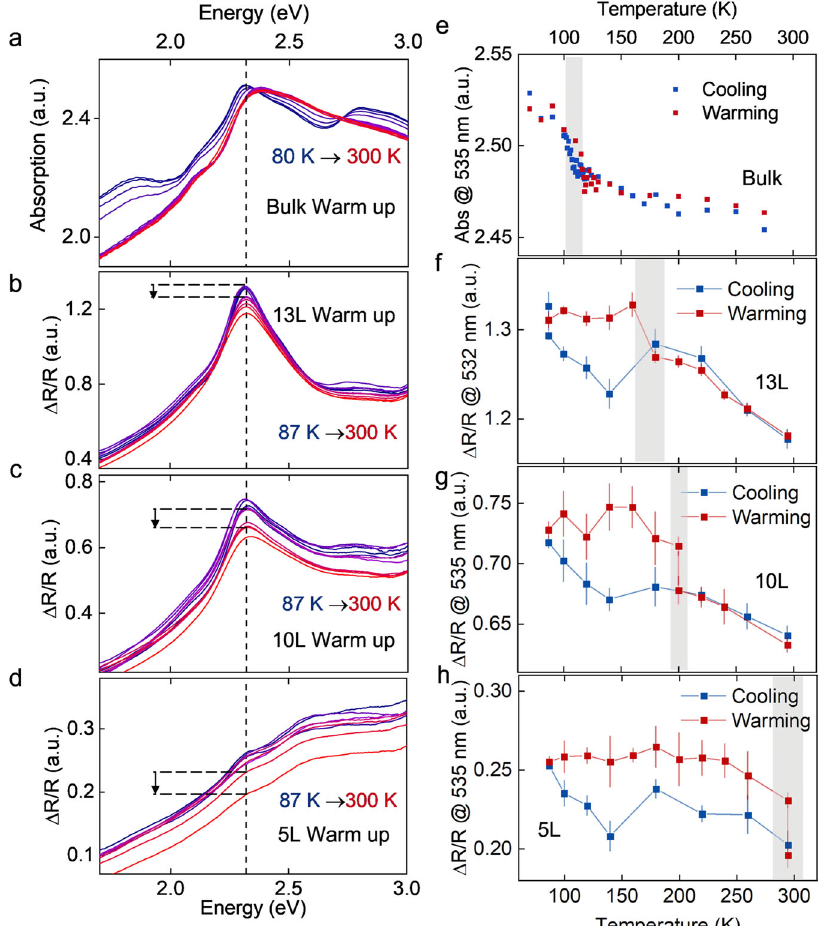
Fig. 3 Spin-crossover transitions measured by absorption and re fl ection contrast spectroscopies. a – d Absorption for the bulk sample and re fl ection contrast spectra for 13, 10, and 5 L samples, respectively, during the warmup process. The arrow in indicates the abrupt amplitude change that is attributed to the LS → HS transition. The abrupt change in c occurs after 0.2 h wait time at 220 k, and that in d occurs after 1 h wait time at room temperature. e – h The absorption/re fl ection contrast amplitudes were taken at 535 nm (as indicated by the dashed vertical lines in a – d ) in a cooldown-warmup thermal cycle. The gray area indicates the extracted LS → HS transition temperature range. The error bars in f – h were obtained as the standard deviation from multiple measurements around the same sample